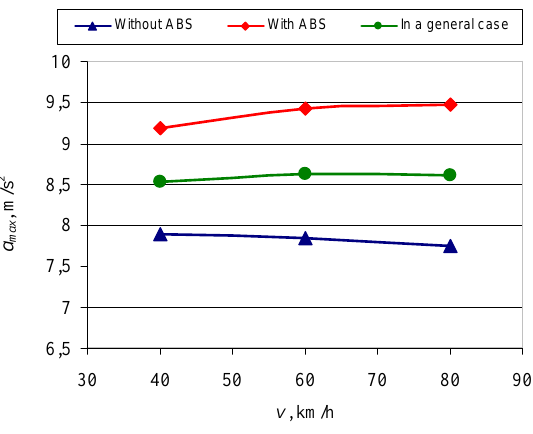
Fig 5. The dependence of the maximum deceleration on the initial speed of movement of the vehicle